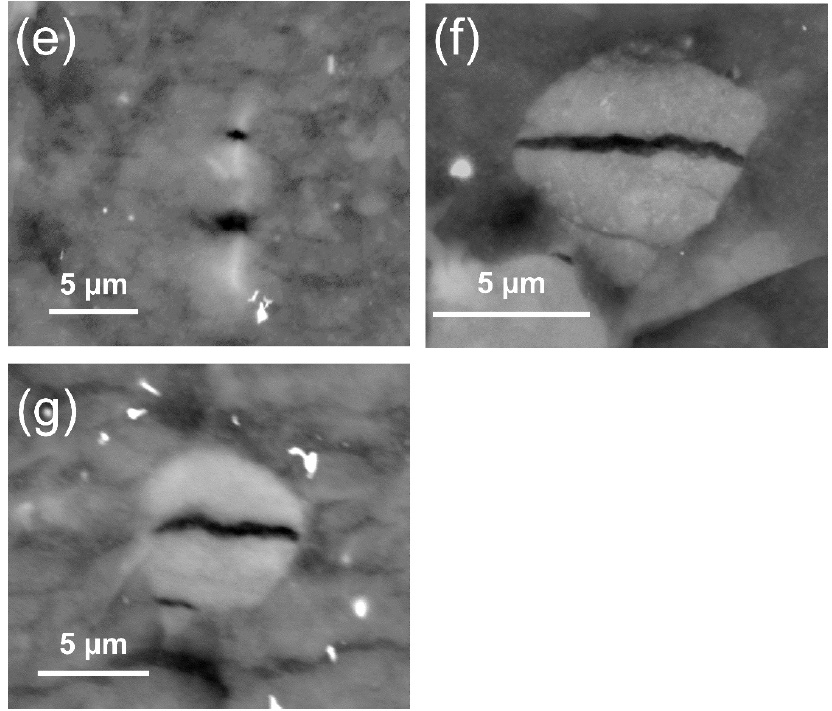
Figure 8. SEM backscattered electron imaging of interrupted fatigue sample surface showing internal silica agglomerate fracture at one visible ( a – c ) or multiple ( d – g ) locations (200% of local strain and 40% of N i , loading direction is vertical).